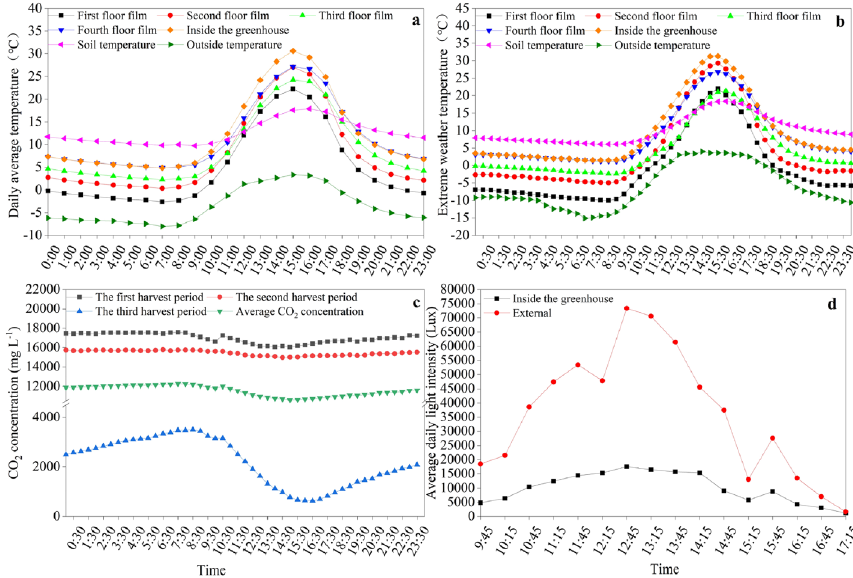
Figure 12. The greenhouse microclimate during the winter production period from December 2017 to February 2018. ( a ) Average temperature; ( b ) extreme weather temperature; ( c ) CO 2 concentration during winter production period; ( d ) average light